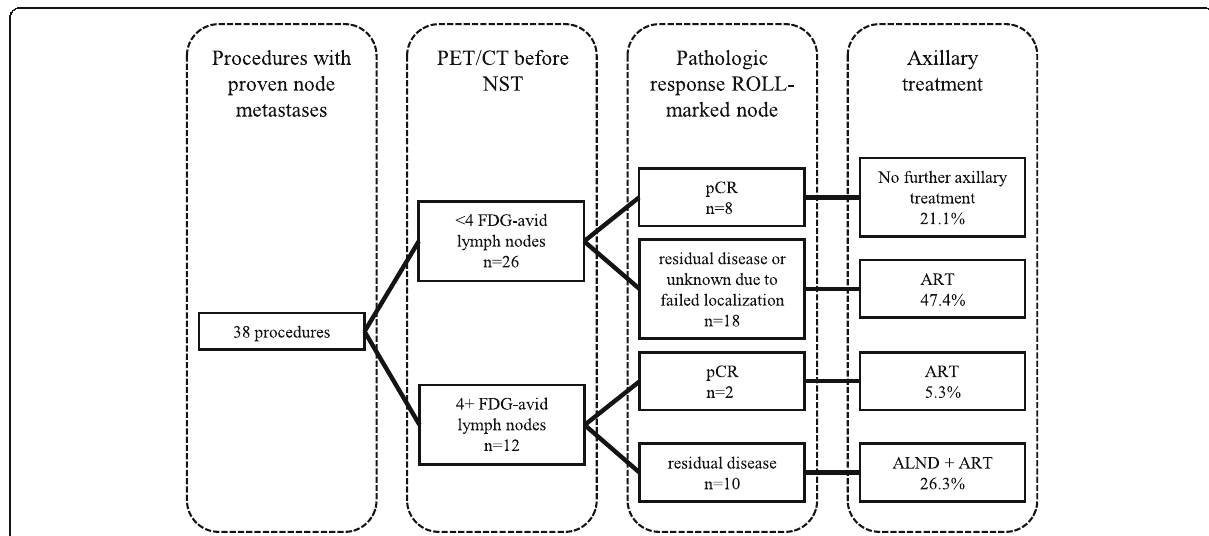
Fig. 4 Tailored axillary treatment in patients by combining pretreatment 18F-FDG PET/CT, neoadjuvant systemic treatment (NST), and pathologic response of a ROLL-marked node that was tumor-positive prior to NST. PET/CT positron emission tomography combined with computed tomography, ROLL radioguided occult lesion localization, pCR pathologic complete response, ART axillary radiotherapy, ALND axillary lymph node